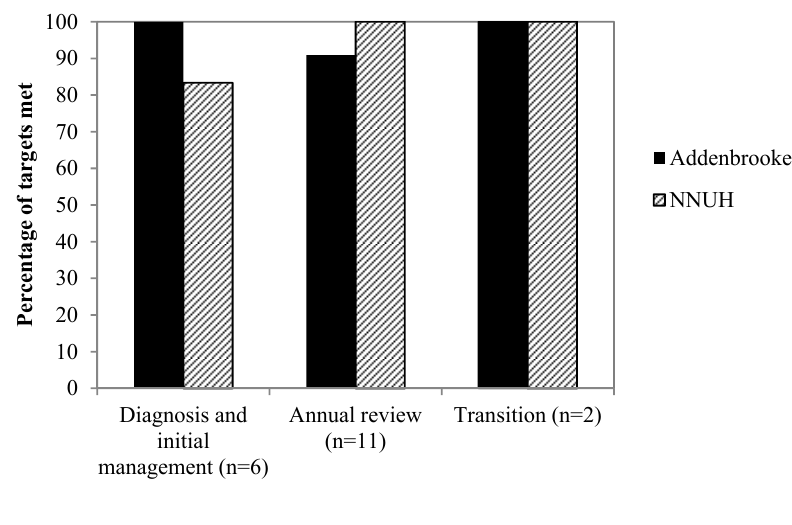
Figure 1. Comparison of the percentage of targets reached in each quality outcome measures (QOM) section between Addenbrooke’s Hospital (AH) (solid bars), and Norfolk and Norwich Hospital (NNUH) (hashed bars), showing the majority to targets being reached in each